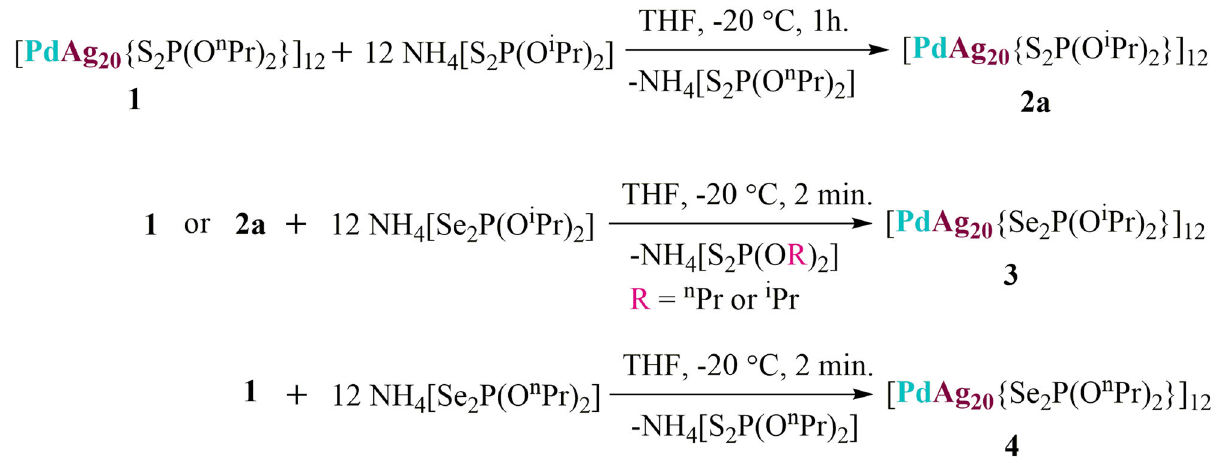
Fig. 1 Synthesized compounds. Synthesis of dichalcogenolate protected Pd-Ag alloy NCs 2a , 3 and 4 via ligand exchange